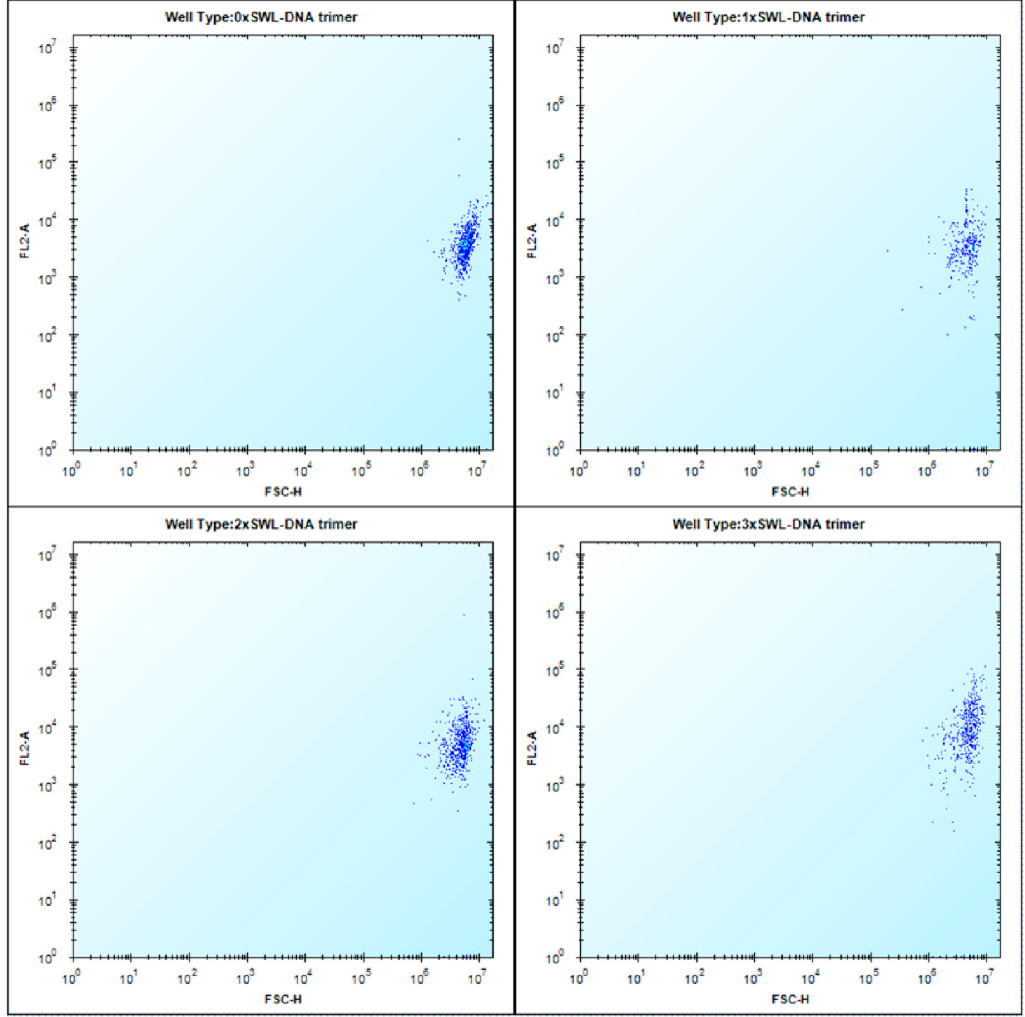
Figure A6. Flow cytometry raw images of SWL-functionalized DNA trimers to PC-3 cells. Cells were treated as described in 4.2 and analyzed using an iQue screener (Intellicyt). Elevated signals at up to intensities of 10 5 in FL2-A (filter 585/40 nm) indicated enhanced binding of 3xSWL-DNA trimers to PC-3 cells (lower right image).